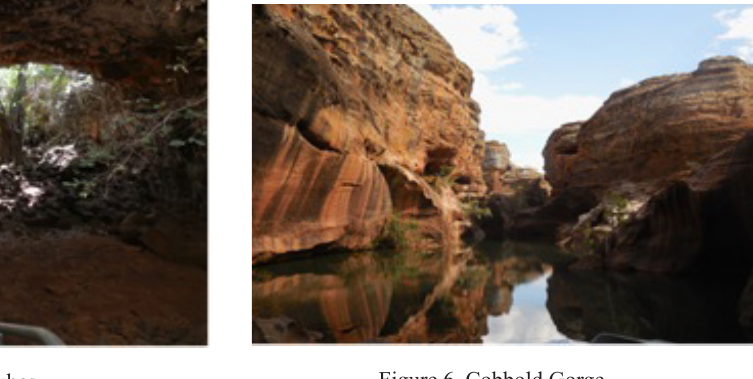
Figure 5. Undara Lava Tubes Figure 6. Cobbold